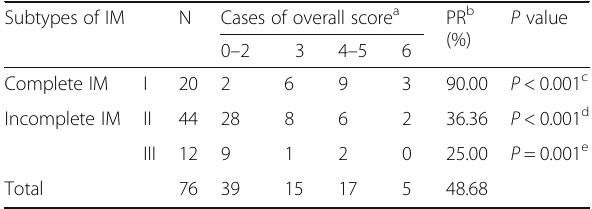
Table 1 Expression of GCRG213p in gastric IM subtypes